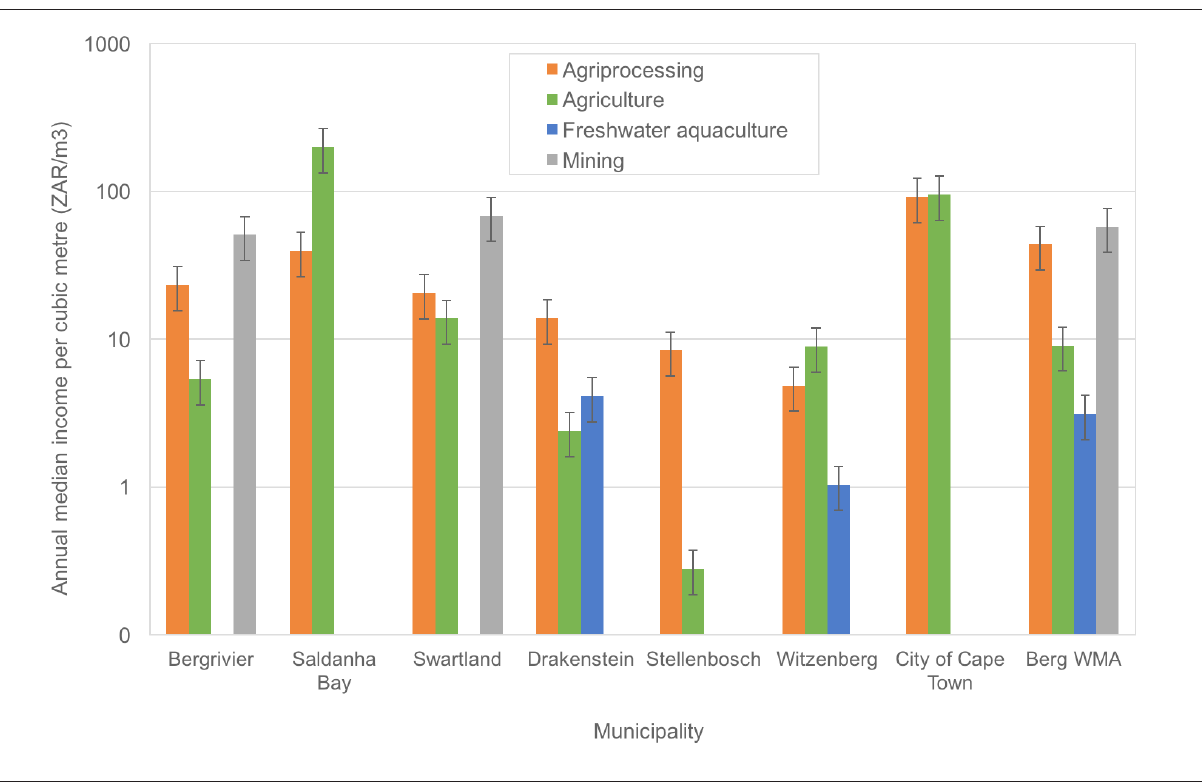
7 South African Journal of Science